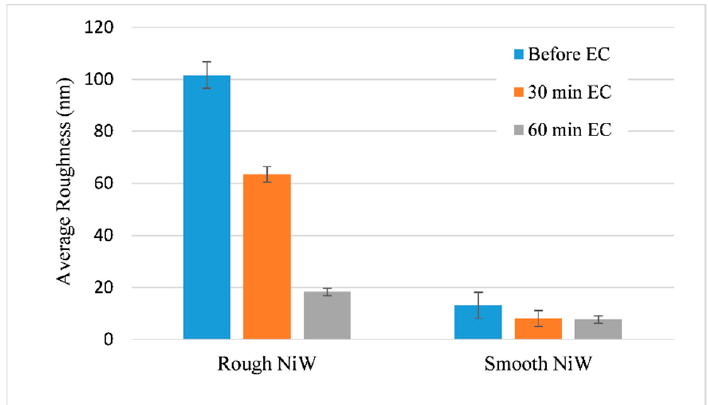
Figure 10. The average roughness of the NiW coatings before and after EC tests, as evidenced by AFM observation.